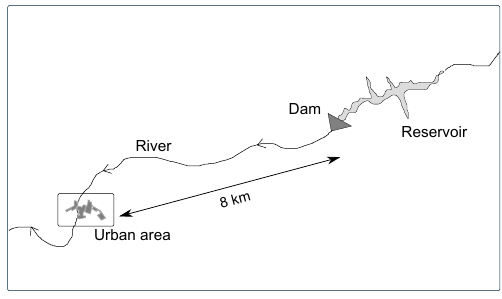
Fig. 6. Overall scheme of the urban area downstream of the